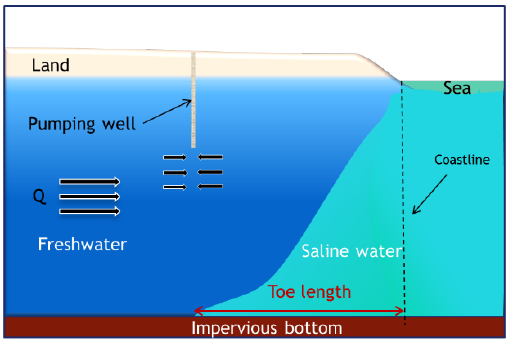
Figure 1. Simplified diagrams of a coastal unconfined aquifer showing the main seawater intrusion (SWI) metrics.